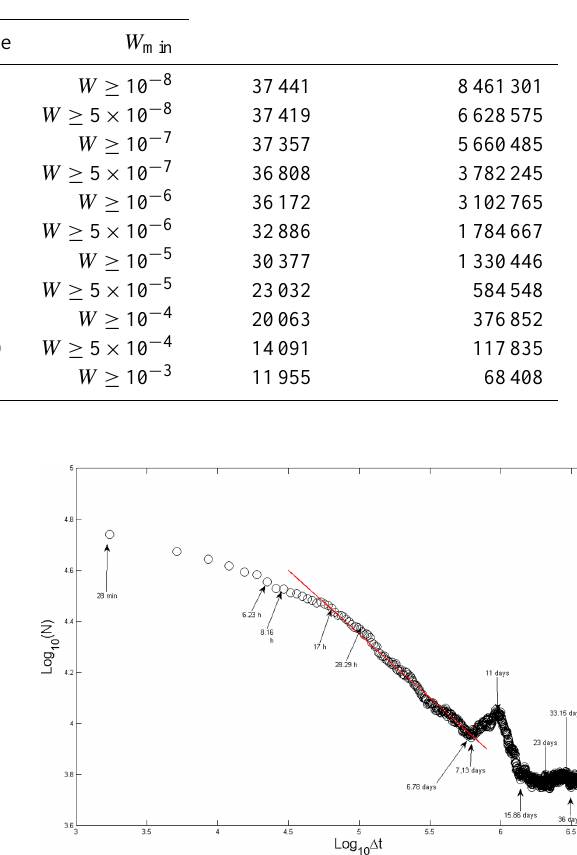
Fig. 5. Distribution of time intervals (in s) between any two nodes in the initial network E 0 . N is the number of time intervals of 1t seconds between any two earthquakes in a space–time window of 50km and 40days. The red line represents a reference line with the slope of −